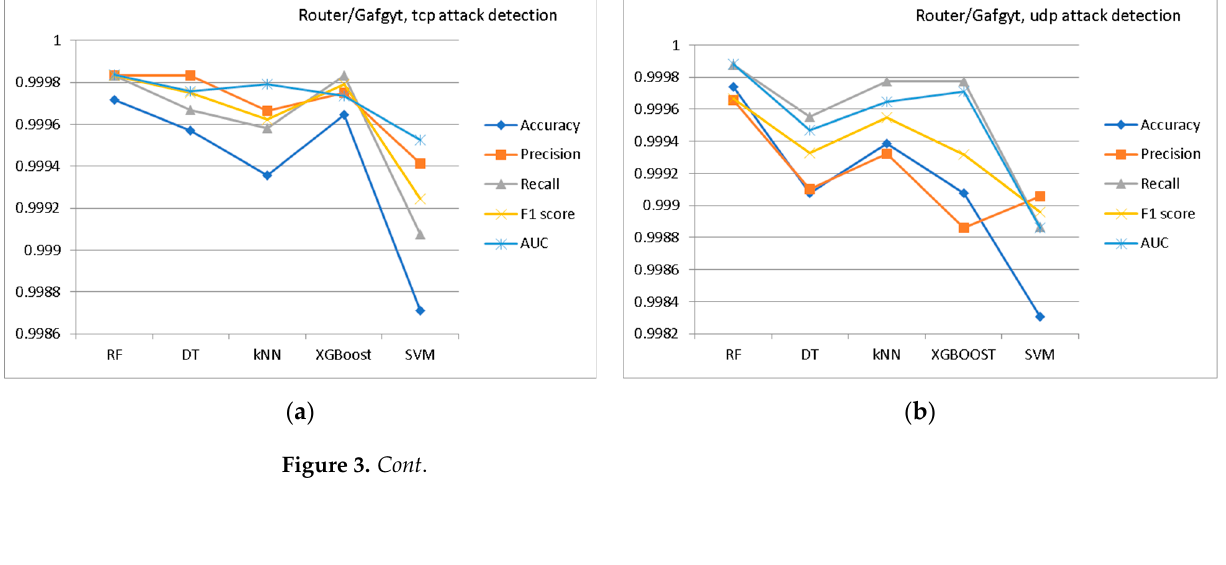
( d ) Figure 3. Comparison of different MLA efficiencies (decision tree—DT, random forest—RF, K- nearest neighbor—KNN, extreme gradient boosting—XGBoost, support vector machine—SVM) for Router/Gafgyt botnet detection: ( a ) TCP attack; ( b ) UDP attack; ( c ) HTTP GET attack; ( d ) DNS tunneling. ( a )